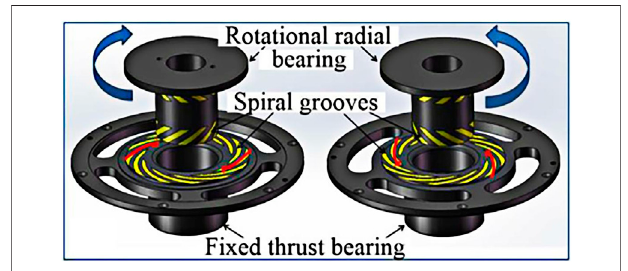
FIGURE 13 | Details of hydrodynamic bearings (Rong Xue, 2019).